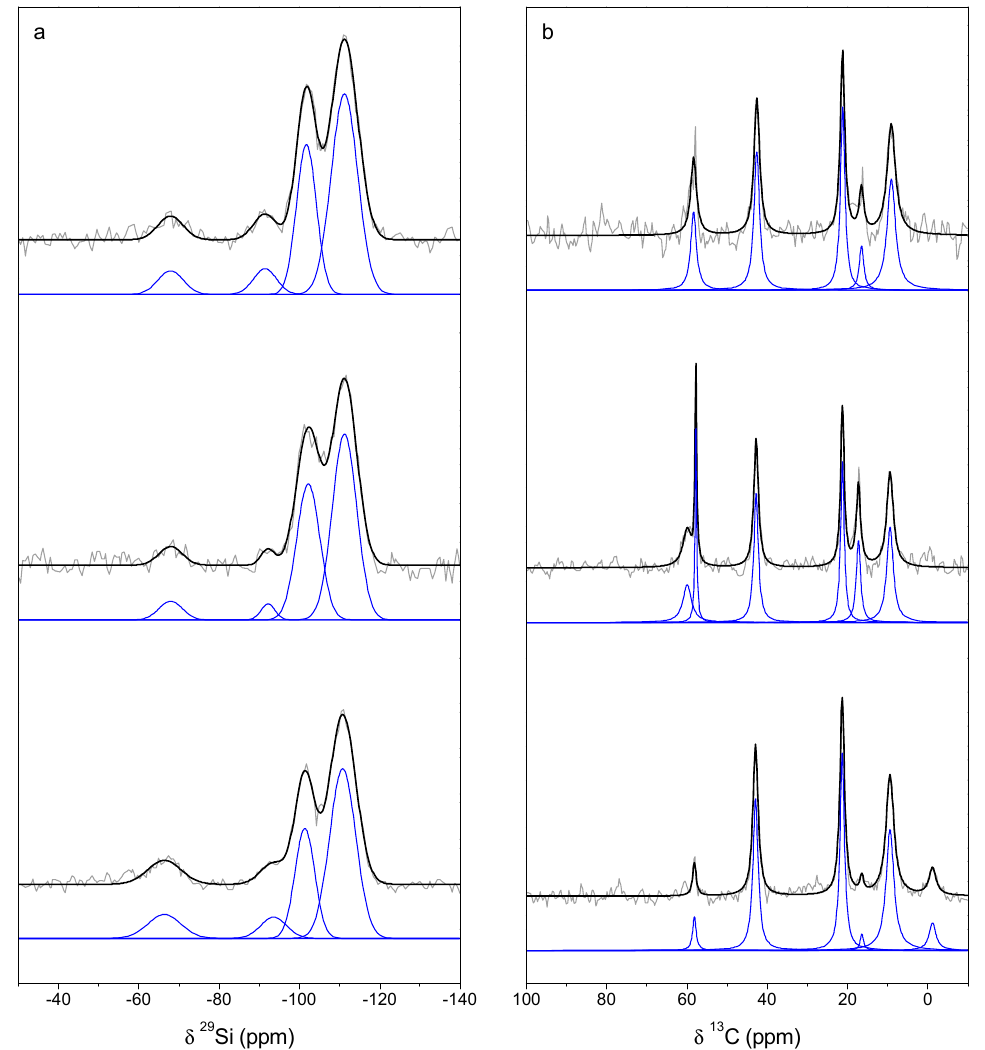
Figure 2. Experimental and fitted 29 Si MAS NMR ( a ) and 13 C CP/MAS NMR spectra ( b ) of samples 0.11-E (top), 0.11-Au-17d (middle) and 0.20-ox-Au-8d (bottom). Table 3. Population of Si species (%) as determined by 29 Si MAS NMR.